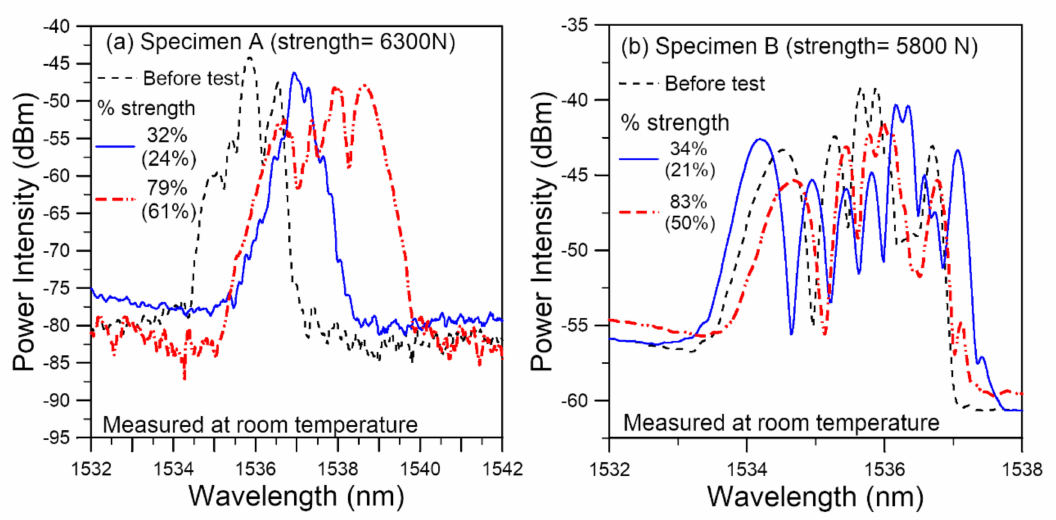
Figure 10. FBG spectra of hygrothermally treated specimens under various tensile loads shown as a percentage of the current specimen strength as well as percentage of the average virgin specimen batch strength (bracketed numbers) from ( a ) specimen A and ( b ) specimen